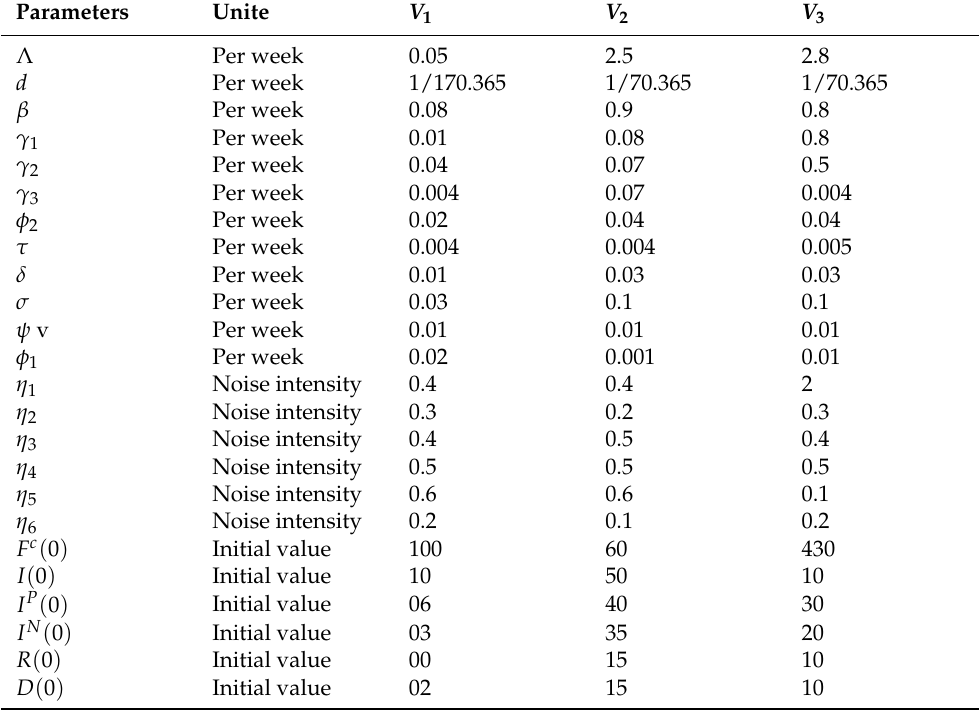
Table 1. Values of the parameters for simulating Model